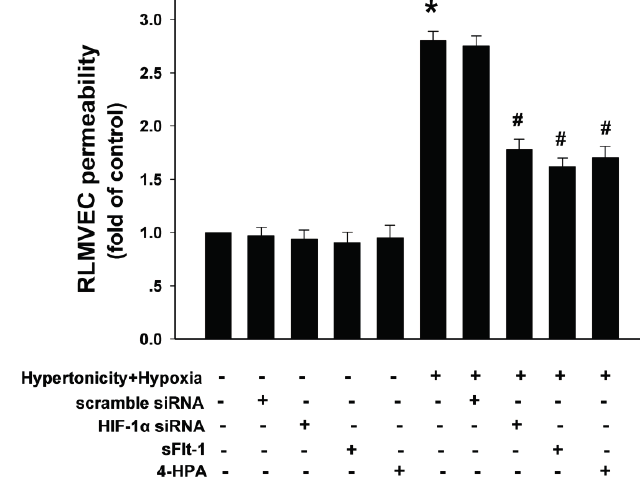
Figure 9. Effects of 4-HPA on monolayer permeability under hypertonicity and hypoxia conditions in rat lung microvascular endothelial cells (RLMVEC). RLMVEC were stimulated with HIF-1 α siRNA, sFlt-1 (1 μ M, vascular endothelial growth factor ( VEGF )antagonist), 4-HPA, hypertonicity and hypoxia, hypertonicity and hypoxia + HIF-1 α siRNA, hypertonicity and hypoxia + sFlt-1, hypertonicity and hypoxia + 4-HPA for 4 h, respectively. The RLMVEC monolayer permeability was measured with FITC-albumin (50 μ M). Data are means ± SD, * p < 0.01 vs. control group, # p < 0.05 vs. hypertonicity and hypoxia